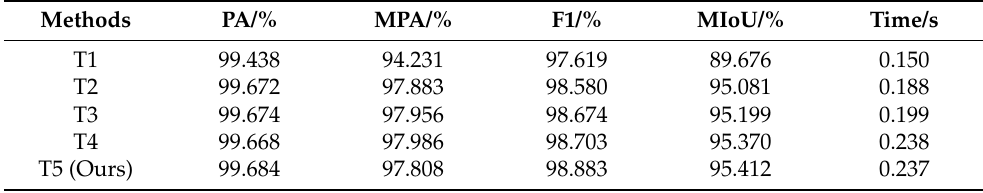
Table 2. The results of each experiment on the actual assembly RGB image